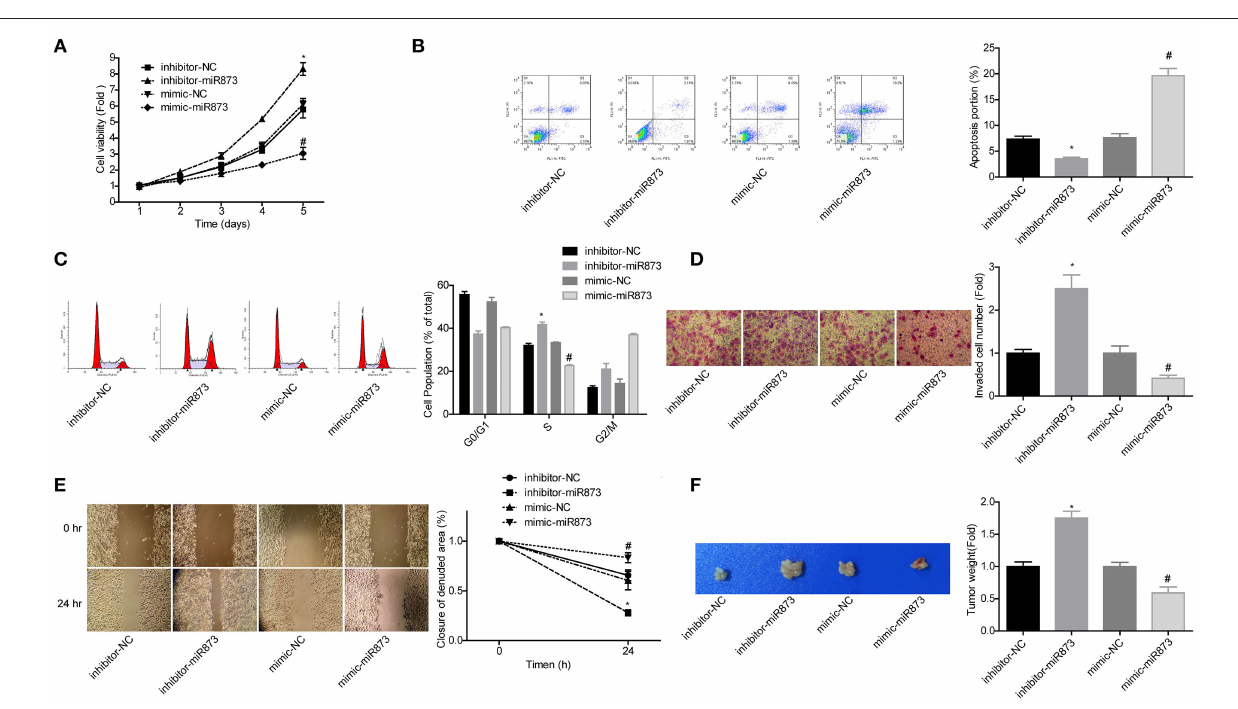
Frontiers in Oncology |